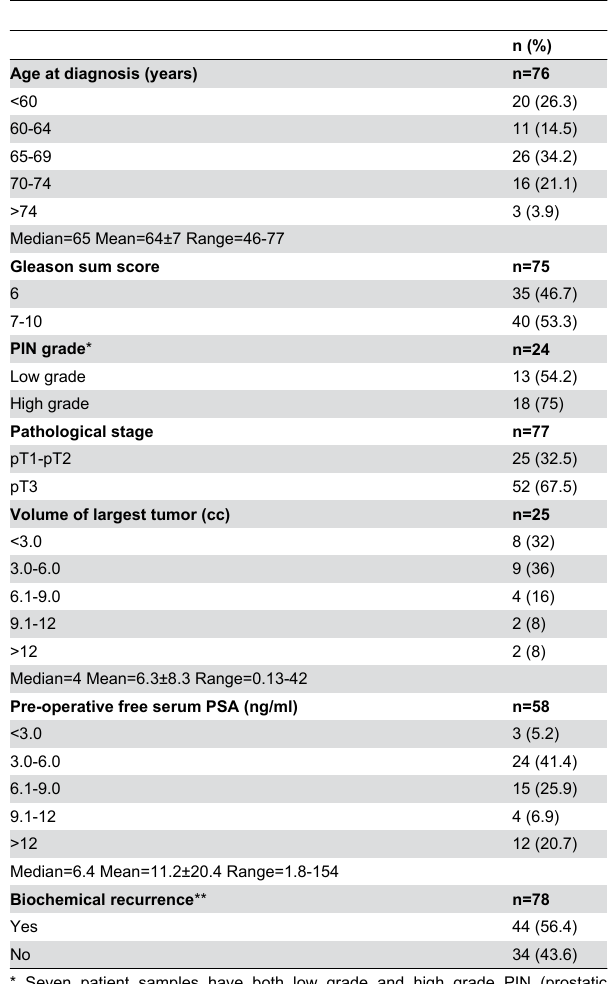
Table 1. Summary of patient and clinical